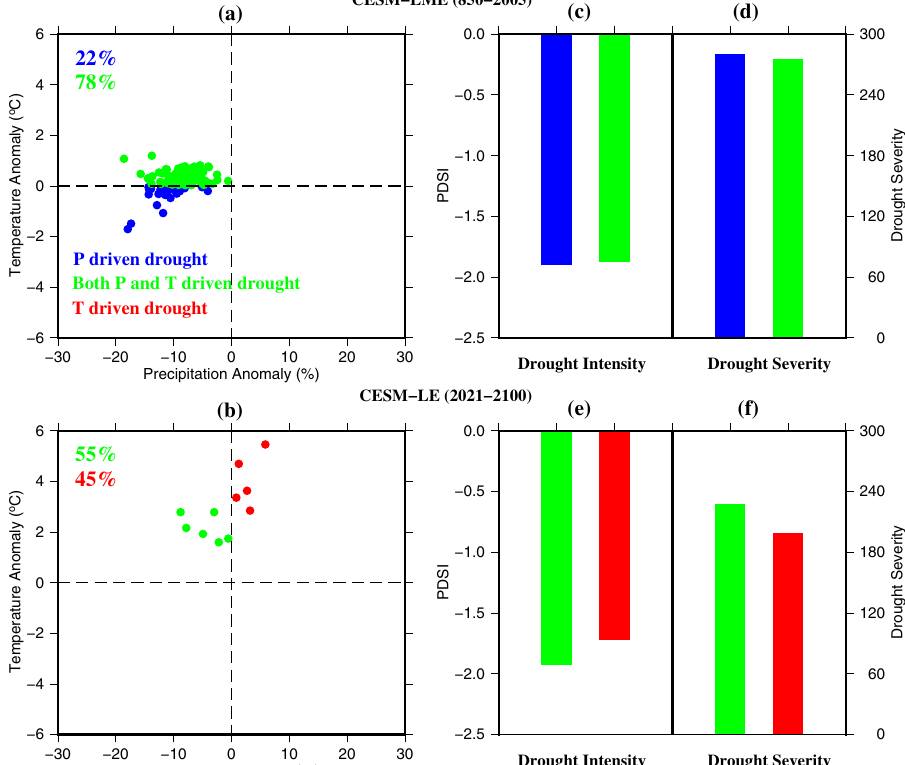
Fig. 8 In fl uence of temperature on the occurrence of 2-year consecutive megadroughts in the past (850 – 2005) and future climate (2021 – 2100). Precipitation and temperature anomaly during megadroughts of 2 consecutive years ( a ) in the last millennium (850 – 2005, CESM-LME) and b future climate (2021 – 2100, CESM-LE) based on Community Earth System Model. Anomalies of precipitation and temperature during the summer monsoon season were estimated against the reference period of 1951 – 2000. c – f Ensemble mean of drought severity and intensity during megadroughts of 2 consecutive years for each category [P-driven drought (blue); T-driven drought (red); and both P- and T-driven droughts] in ( c , d ) the last millennium (850 – 2005, CESM-LME) and ( e , f ) future climate (2021 – 2100,